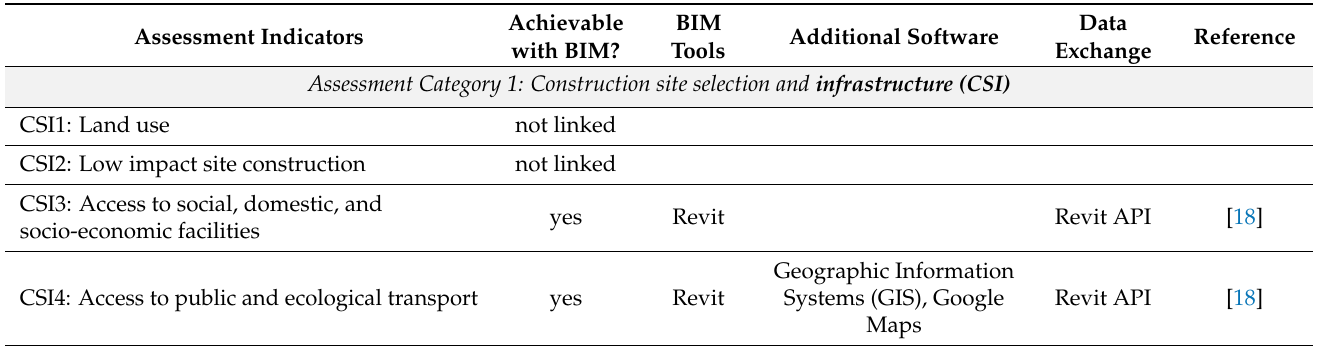
Table 2. Mapping of KBSAF assessment indicators to